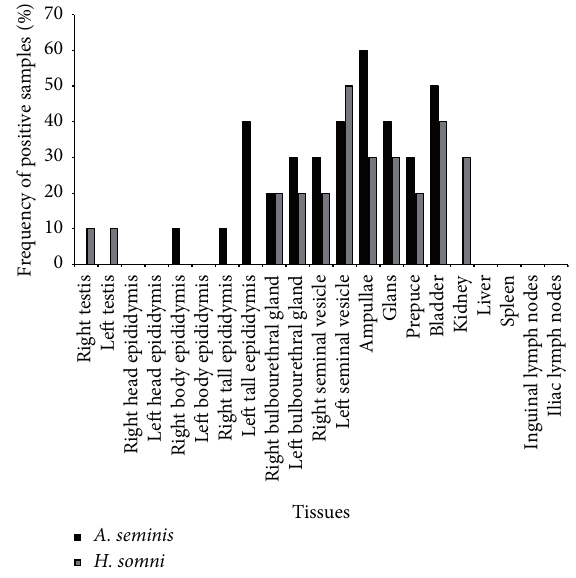
Figure 4: Frequency (%) of positive rams for bacterial isolation of Actinobacillus seminis ( 𝑛 = 10 ) or Histophilus somni ( 𝑛 = 10 ) in tissues after 42 days of experimental infection.